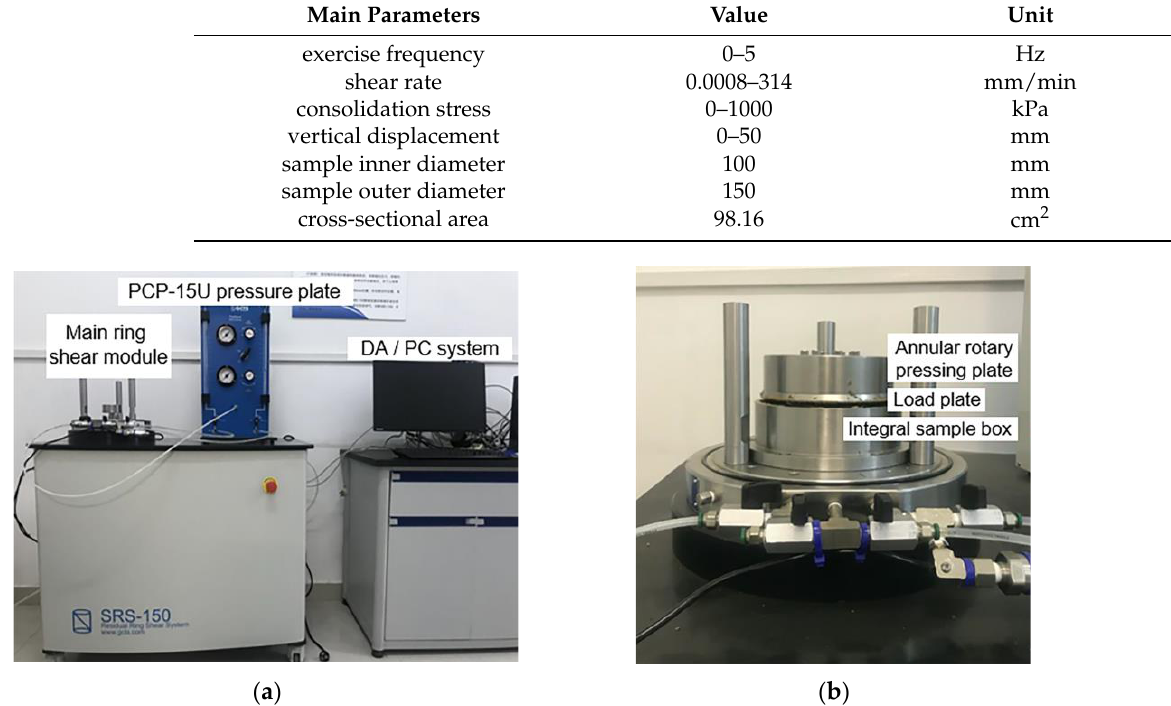
Figure 2. SRS-150 dynamic ring shear test device: ( a ) the PCP-15U pressure plate and the DA/PC system; ( b ) the main ring shear module. Table 1. Main parameters of SRS-150 test device.